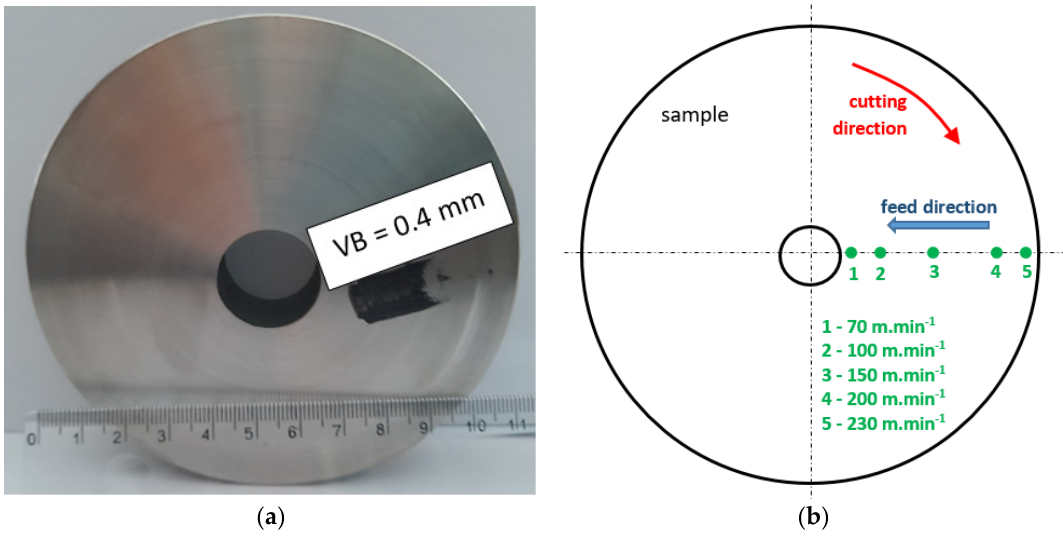
Figure 2. Photo and brief view of the analysed positions, the corresponding cutting speeds on the disk, and the process kinematics: ( a ) photo; ( b ) brief sketch. Residual stresses were measured along the cutting direction (CD) and the feed direc- tion (FD). The XRD patterns were measured by Proto iXRD Combo (Proto Manufacturing Ltd., Montreal, Canada) (CrK α radiation in the plane {211}, sensing depth of about 5 μ m, scanning angles of ± 39°, Bragg angle of 156°, elastic constants for calculation of stresses of ½ s 2 = 5.75 TPa − 1 and s 1 = − 1.25 TPa − 1 , and a collimator of the diameter 1 mm). The weight fraction of retained austenite was measured in the planes bcc{211}, fcc{220}, bcc {200}, and fcc{211} (sensing depth of about 4 μ m, a collimator of the diameter 2 mm).